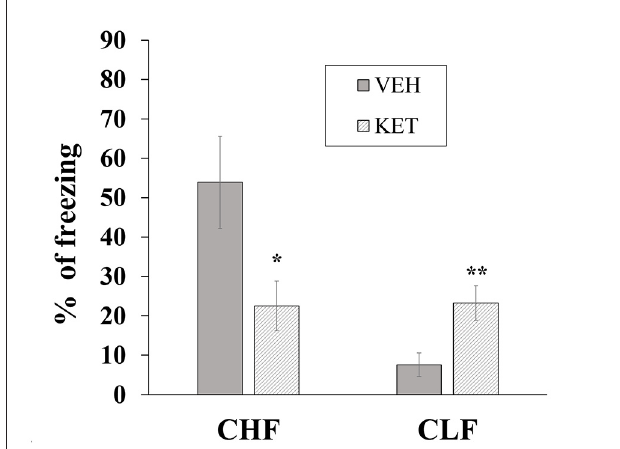
FIGURE 4 | Mean + SEM percentage of time spent freezing in CHF and CLF animals that received ketanserin (KET) or vehicle (VEH) microinjections in the IL cortex. ∗ p < 0.05 KET vs. VEH among CHF animals; ∗∗ p < 0.05 KET vs. VEH among CLF animals.